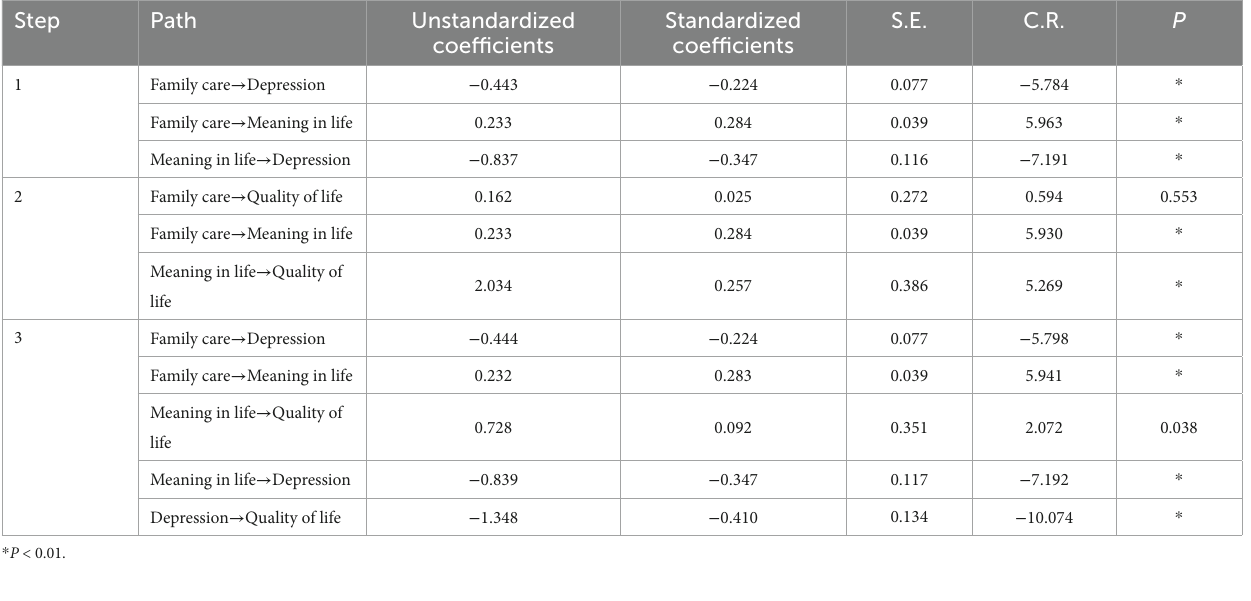
TABLE 4 Results of path analysis ( N = 601).